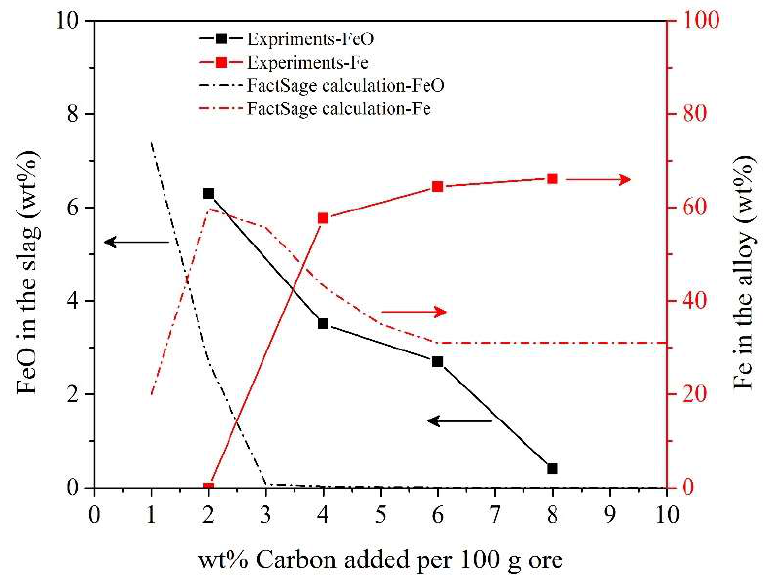
Figure 9. A comparison between experimental results and FactSage calculation on the FeO and Fe concentration in the slag and alloy with the addition of carbon.